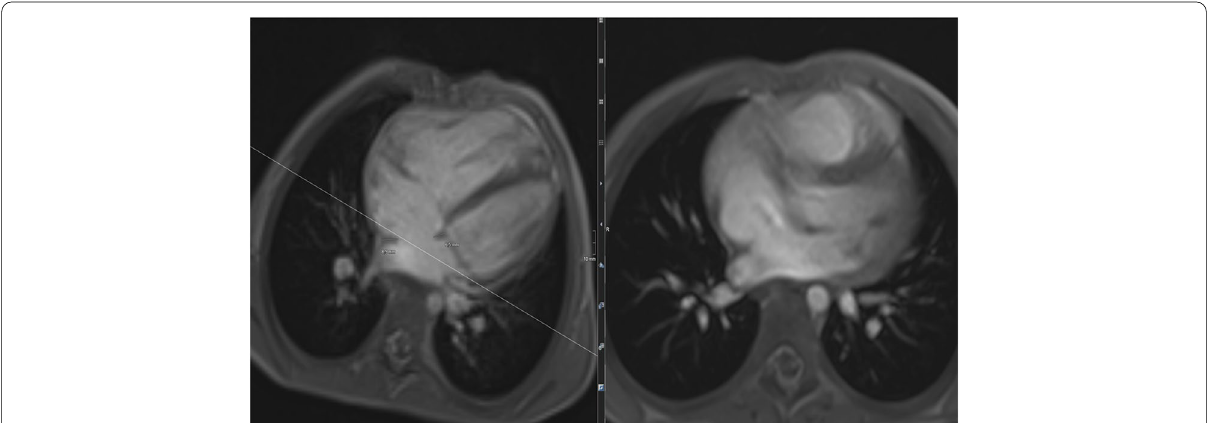
Fig. 8 (Functional imaging): a 4-chamber view and axial CINE allow the measurement of the size of the ASD (diameters) plus the illustration of concomitant “jets” (increased and turbulent flow produces hypointense blood